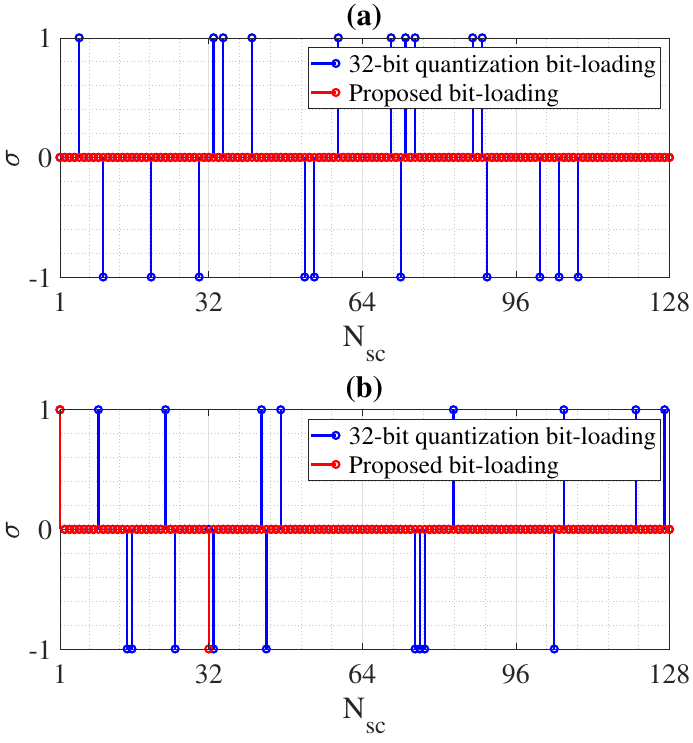
Figure 5. Difference between ideal bit-loading and the proposed scheme compared with the difference between ideal bit-loading and quantized information feedback link in channel realizations ( a , b